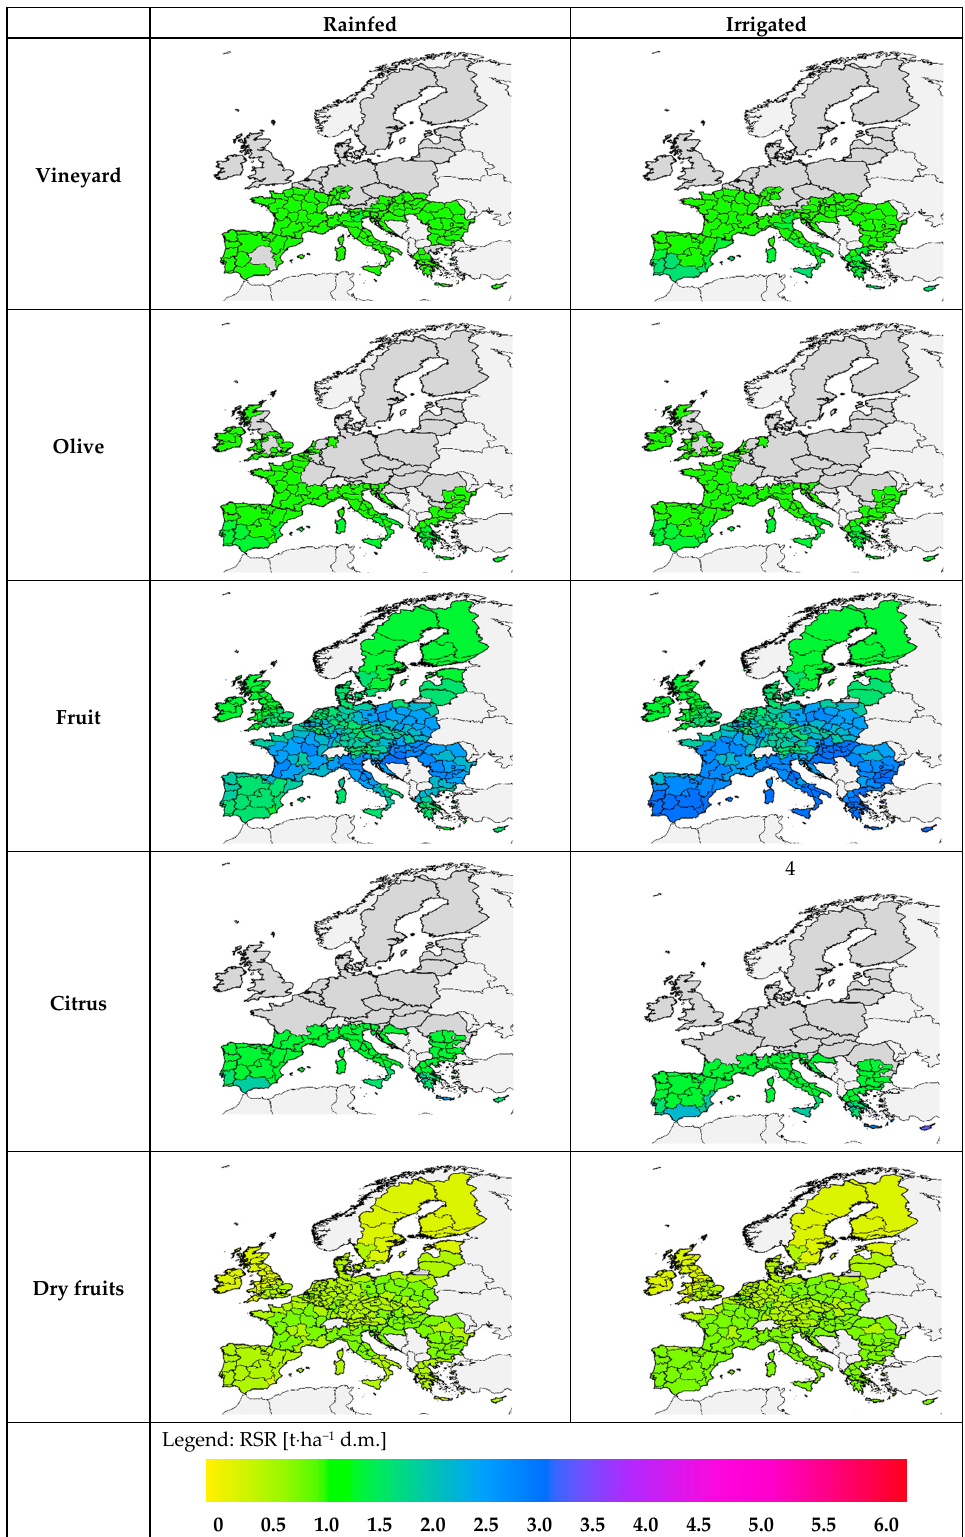
Figure 6. Productivity of pruning residue under rainfed and irrigated conditions estimated as surface ratio RSR (t ⋅ ha − 1 d.m.) for five crop groups by NUT2 geographical unit.